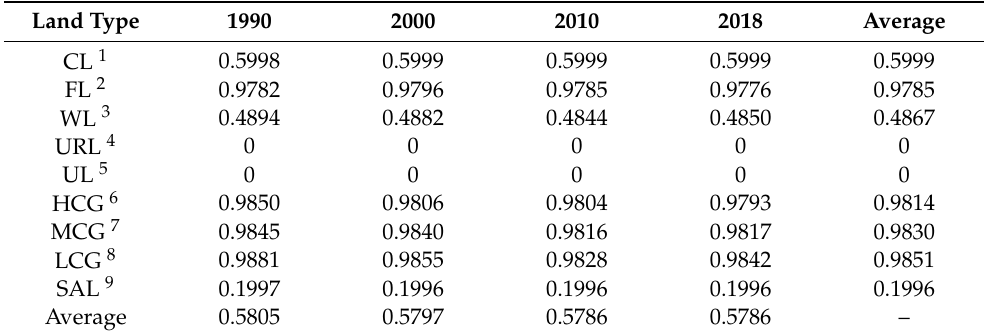
Table 2. Habitat quality index changes of different land use types from 1990 to 2018. Land Type